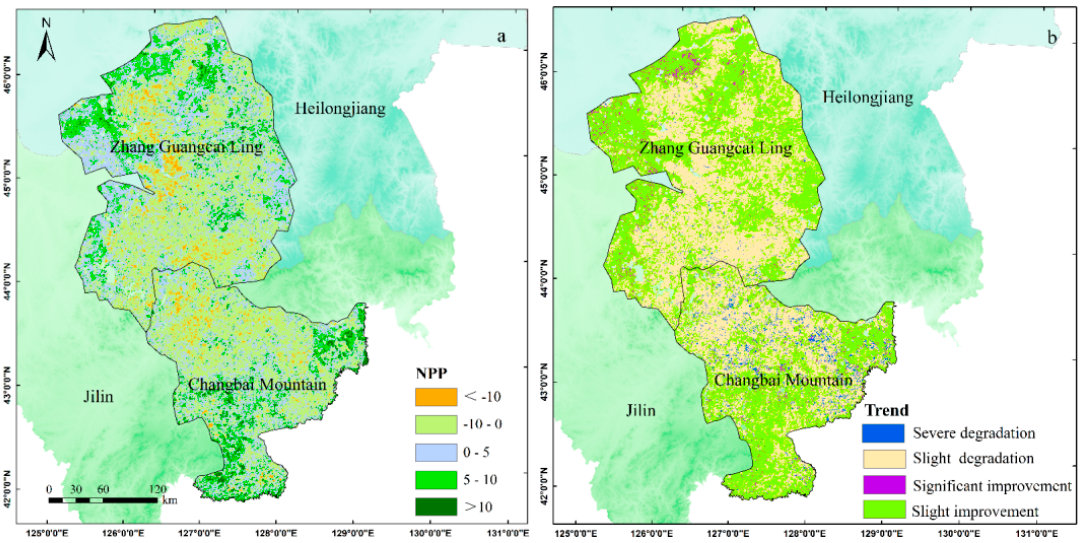
Figure 9. Changing trend of NPP ( a ) and its significance ( b ) in Northeast China, during 2001–2019.